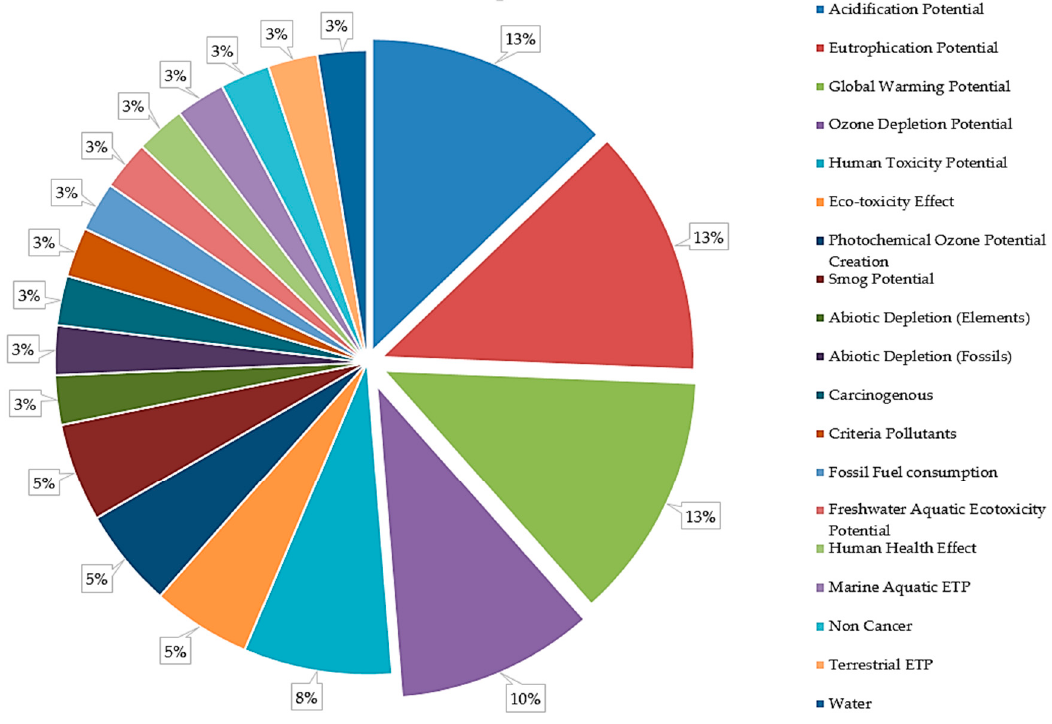
Figure 1. Major impact indicators of LCA.